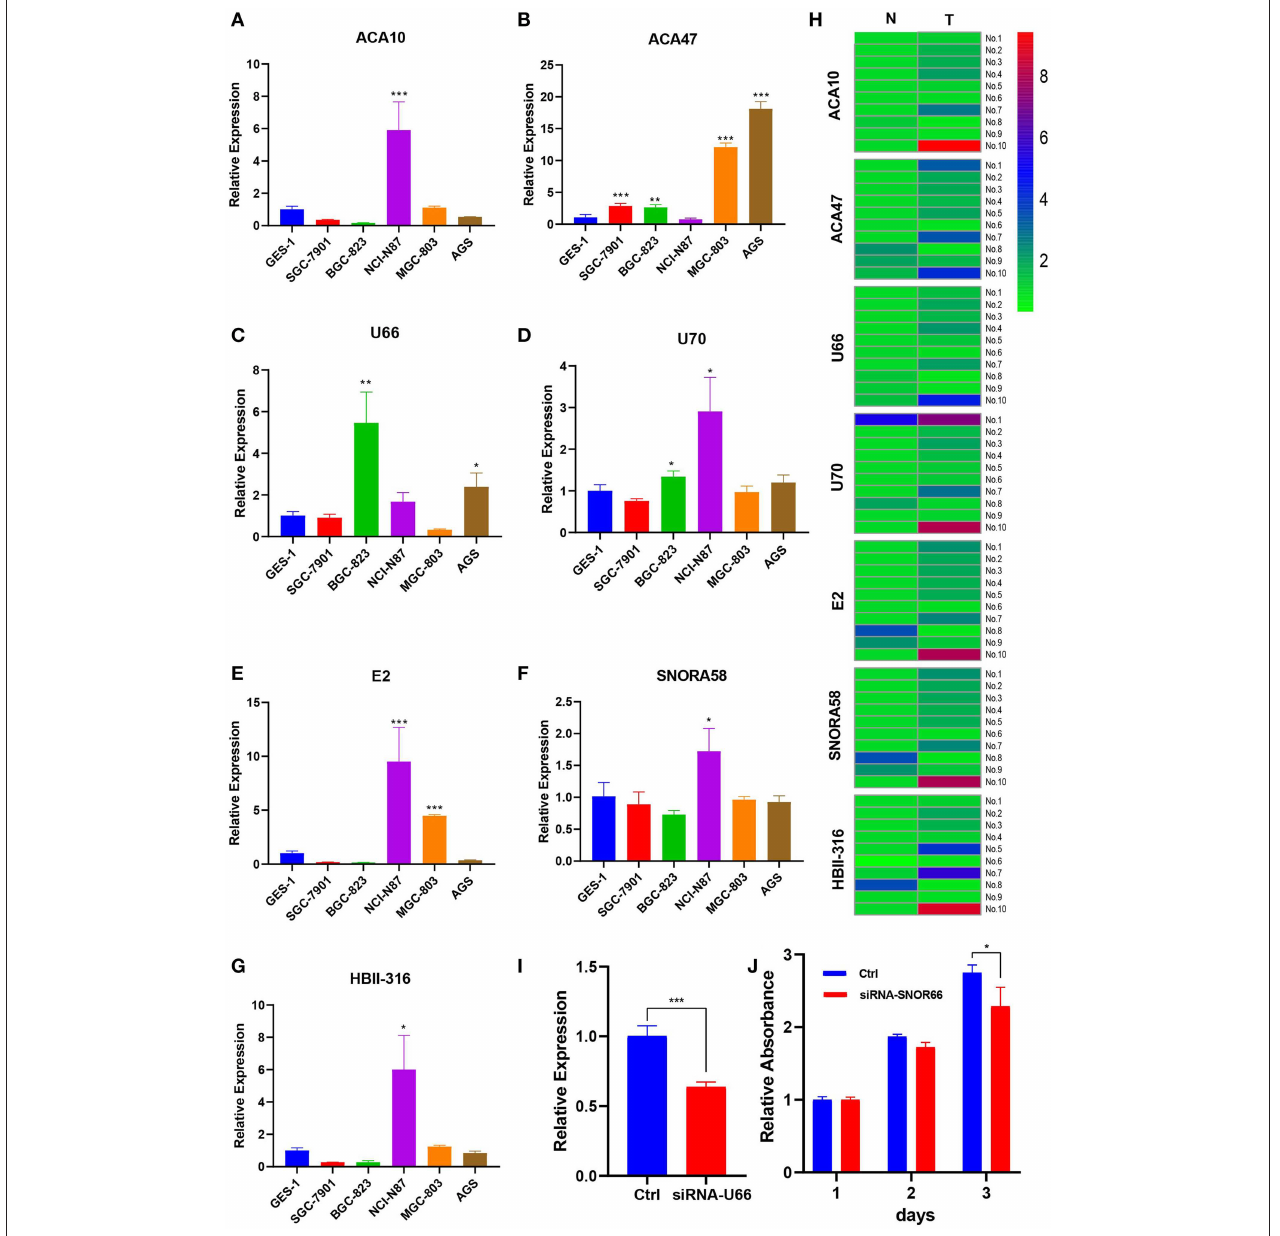
FIGURE 5 | Expression profile of snoRNAs in cell lines and paired tissues. (A–G) Expression profile of snoRNAs upregulated in certain cell lines. (H) SnoRNAs were mainly upregulated in five patient samples. (I) U66 was knocking down by siRNA. (J) Knocking down U66 inhibited cell proliferation. * p < 0.05; ** p < 0.01; *** p <